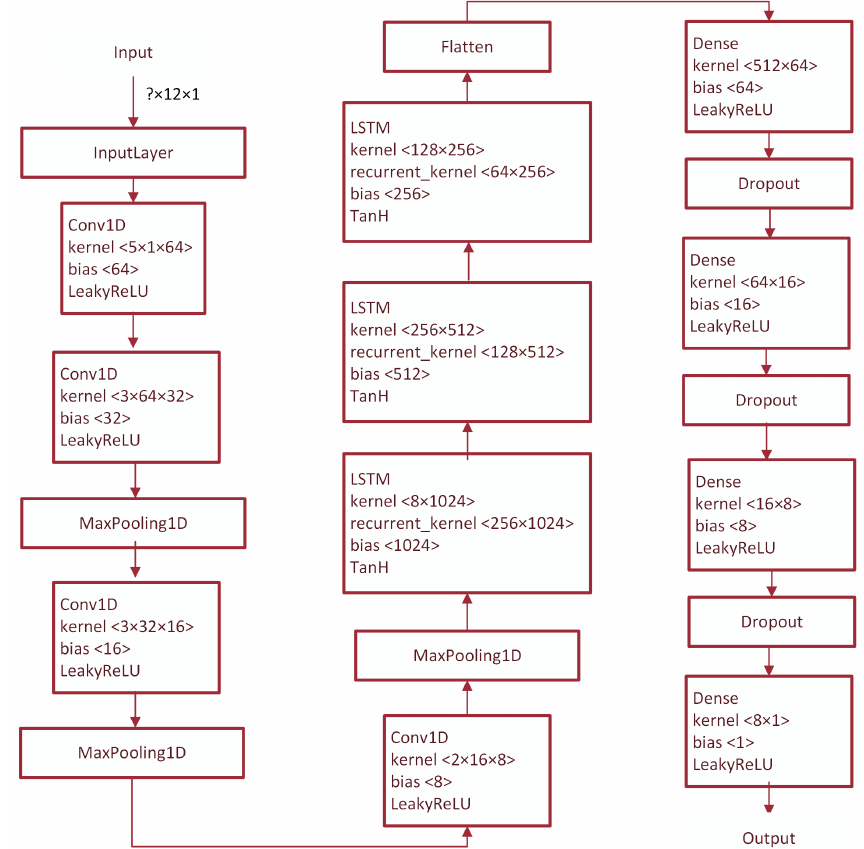
Figure 4. Schematic representation of the architecture of the proposed